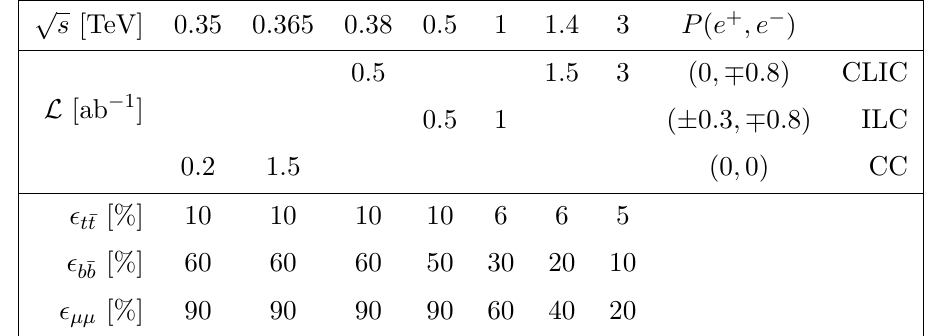
Table 2 . Run scenarios considered and e(cid:11)ective e(cid:14)ciencies employed at the various centre-of- mass energies for the reconstructions of pairs of top quarks, bottom quarks and muons. When two beam polarizations are available, luminosities at each centre-of-mass energy are equally shared between